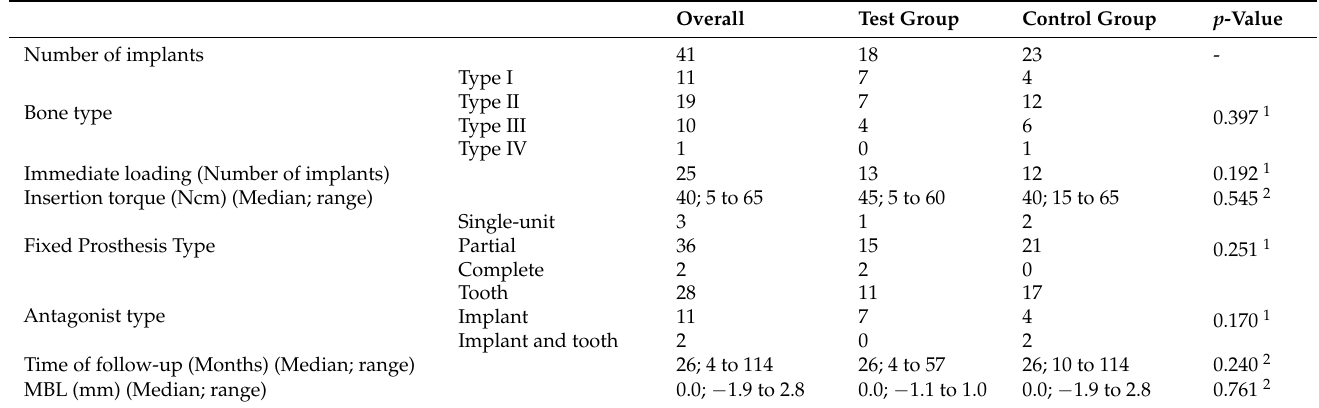
Table 3. Summary of the main results.